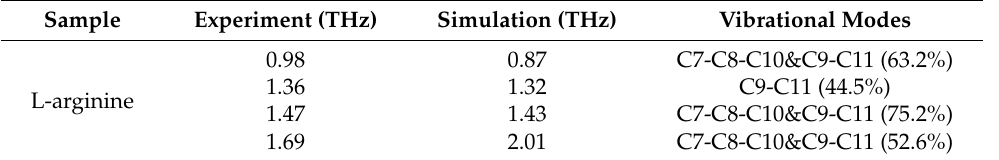
Figure 7. Vibrational modes of L-arginine at ( a ) 0.87 THz; ( b ) 1.32 THz; ( c ) 1.49 THz; ( d ) 2.01 THz obtained by visualization software. Table 2. Vibrational mode assignment of